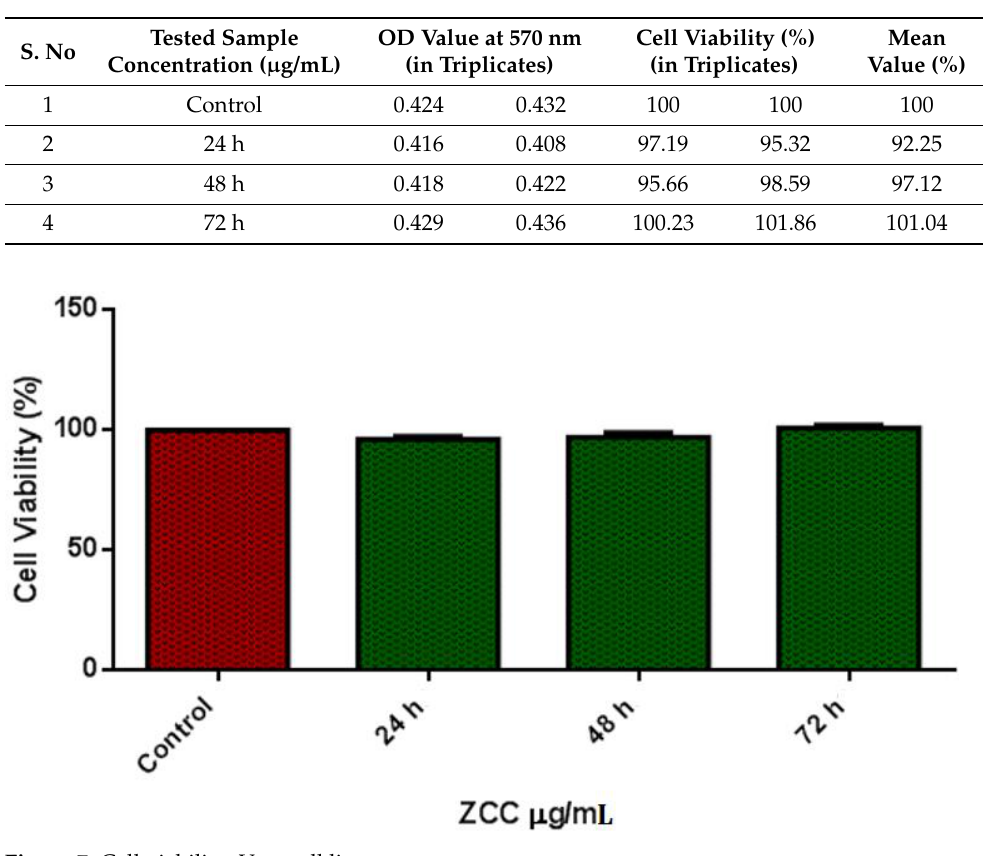
Table 3. Cell viability OD value at 570 nm; control mean OD value: 0.428.